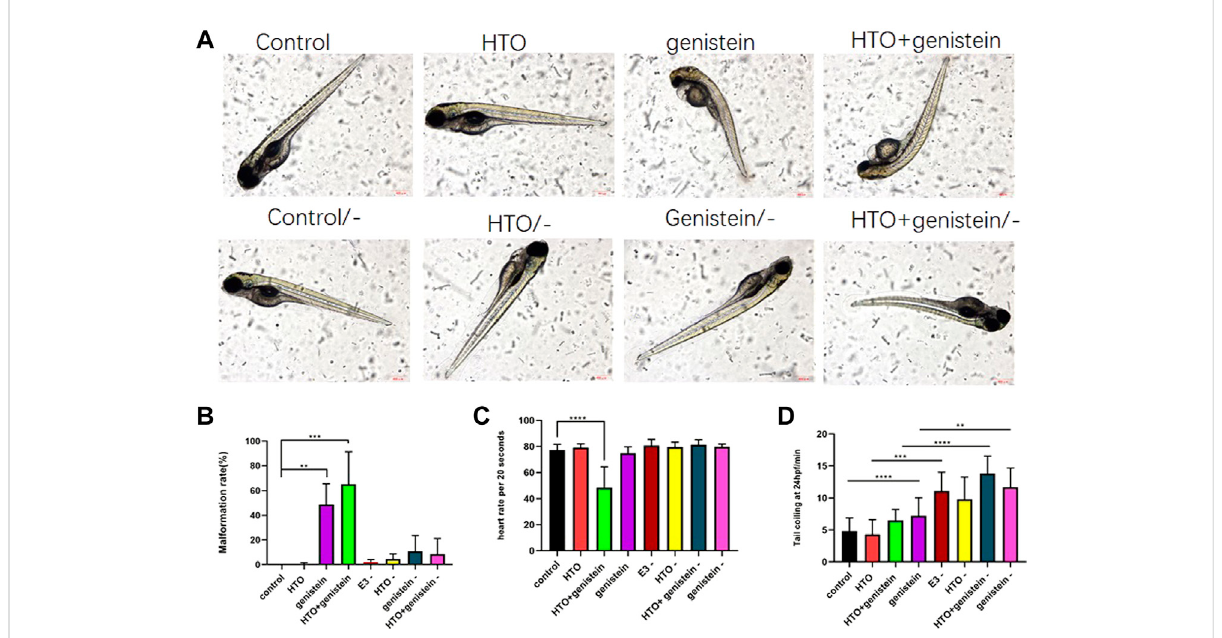
FIGURE 7 Thedevelopmentofzebra fi shduringtheexposureaftercyp19a1bgeneknockout. (A) Themorphologyofzebra fi shlarvae, (B) themalformation rateof96 hpfzebra fi shlarvae, (C) theheartrateofzebra fi shat96 hpf, (D) spontaneous movementofthezebra fi shembryo tailat24 hpf.10 samples were taken from each parallel samples of each experimental group. “ - ” mean cyp19a1b is knockdown. ** p < 0.01, *** p < 0.001, **** p <